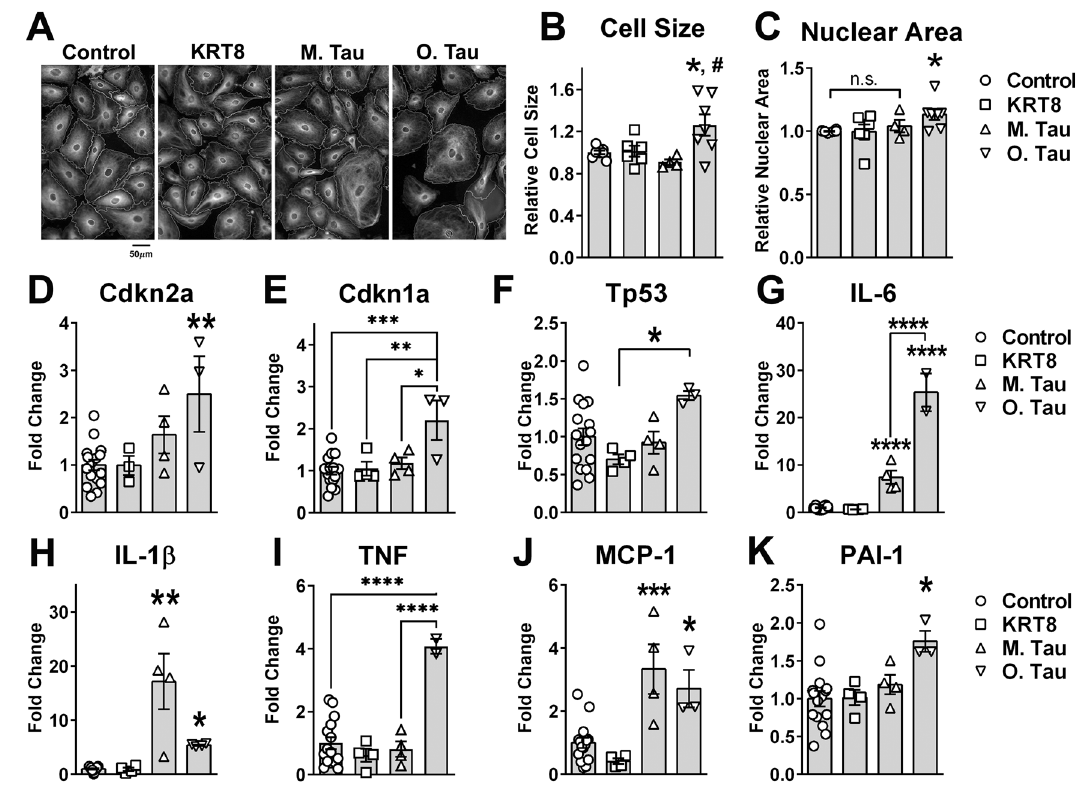
Fig.3|Solubletauaggregatesinducesenescence/SASPinprimaryhumanbrain microvascular endothelial cells. A – C Soluble tau aggregates increase cell and nuclear size in primary human brain microvascular endothelial cells (HBEC). A Representative images of HBEC treated with recombinant human cytokeratin-8 (KRT8),monomerictauprotein(M.Tau),solubletauaggregates(O.Tau),orvehicle (Control). B Quantitative analyses of cell size from data shown in A.